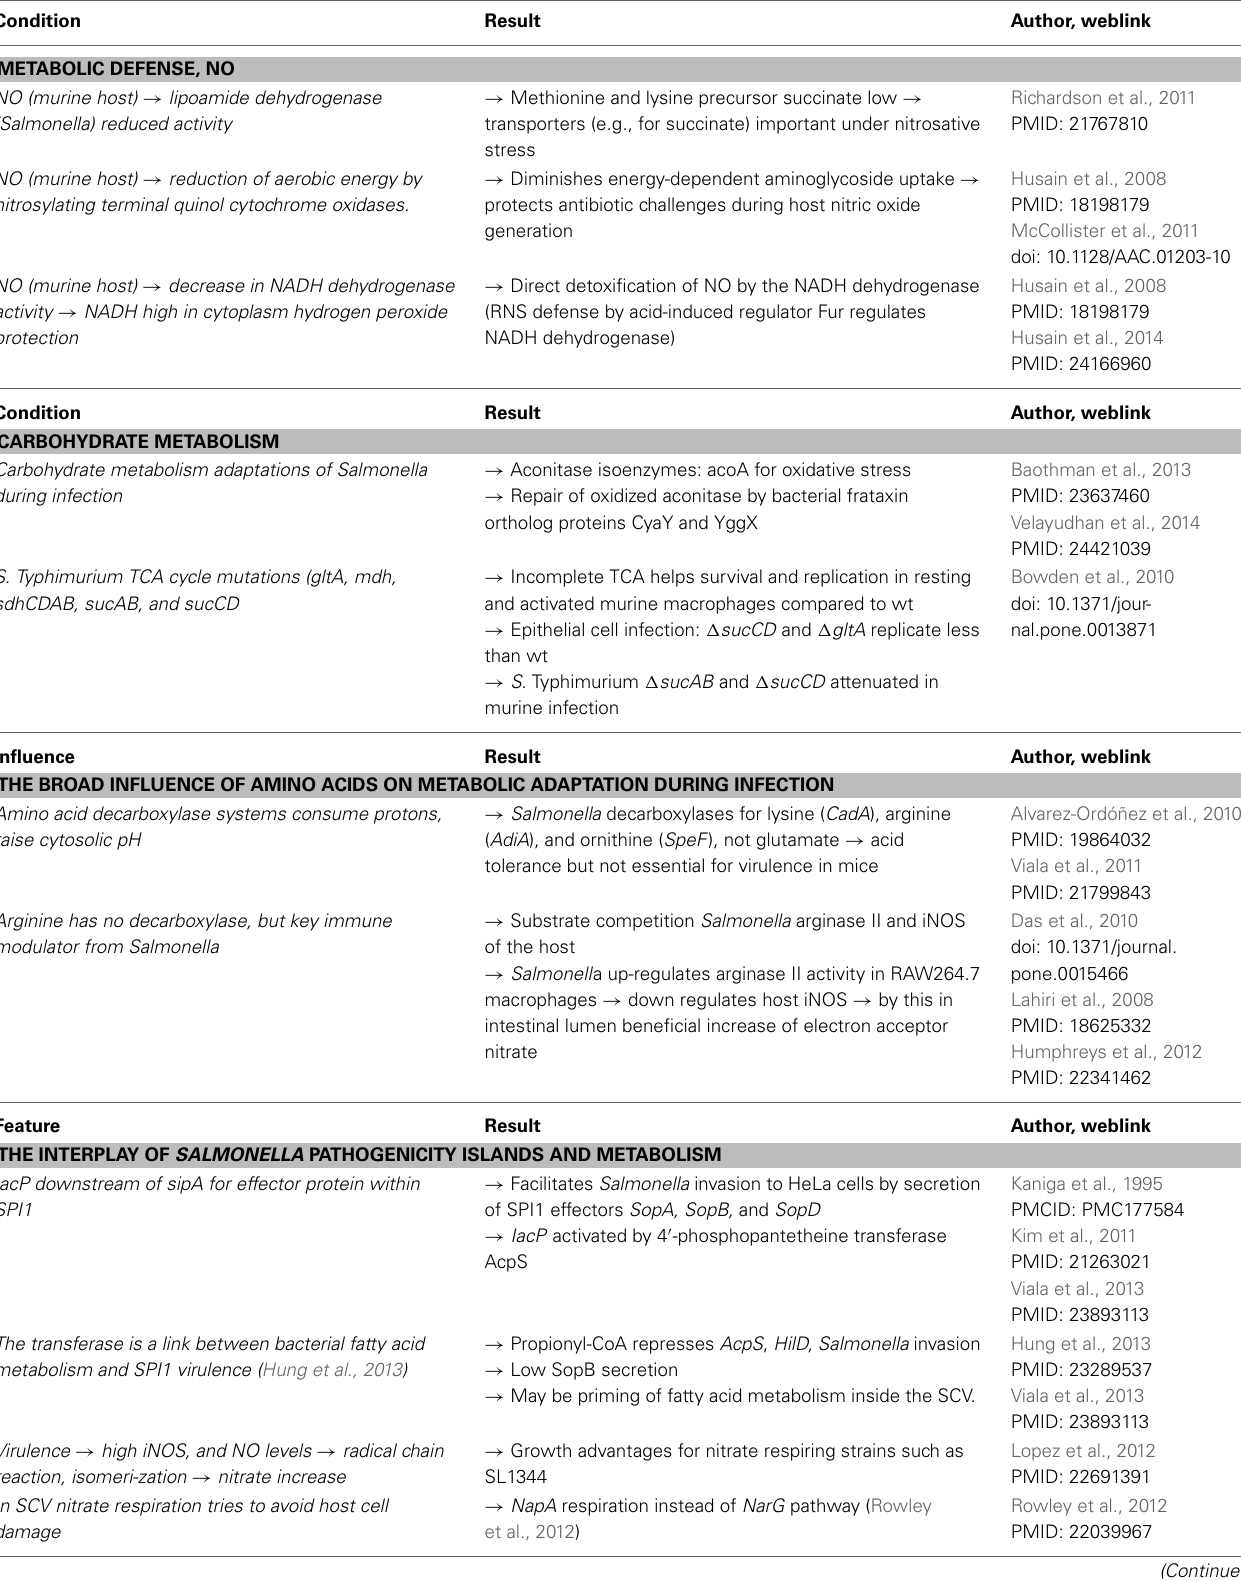
Table 3 | Studies on different metabolic conditions for Salmonella